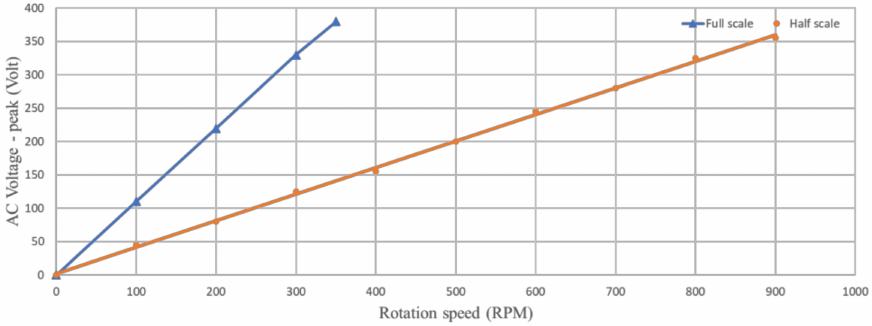
Figure 1. Full-scale (blue triangle) and half-scale (orange circle) AC voltages against the rotation speed of the physical model test of the OIST WEC generator in Maldives after